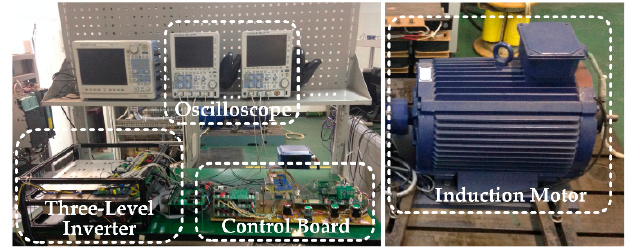
Figure 8. The experimental prototype of neutral-point-clamped three-level inverter. Table 2. Parameters of the experimental